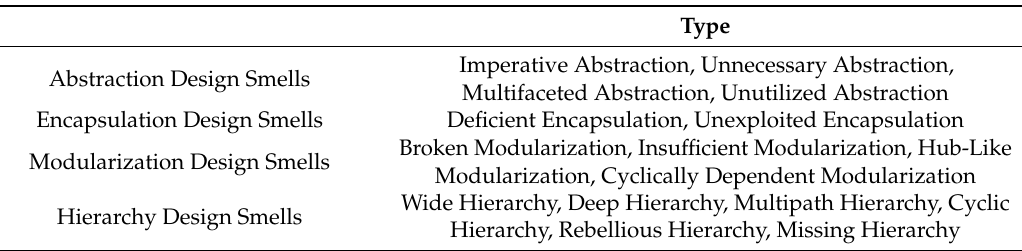
Table 3. Design smells detected.